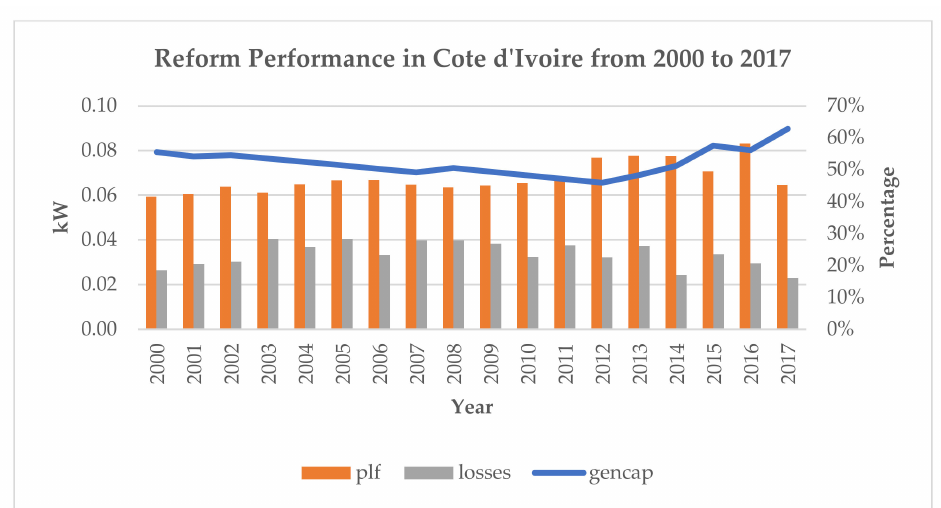
Figure 4. Evolution of plant load factor (in percentage), technical network losses (in percentage) and installed generation capacity per capita (in kilowatt) in Cote d’Ivoire.